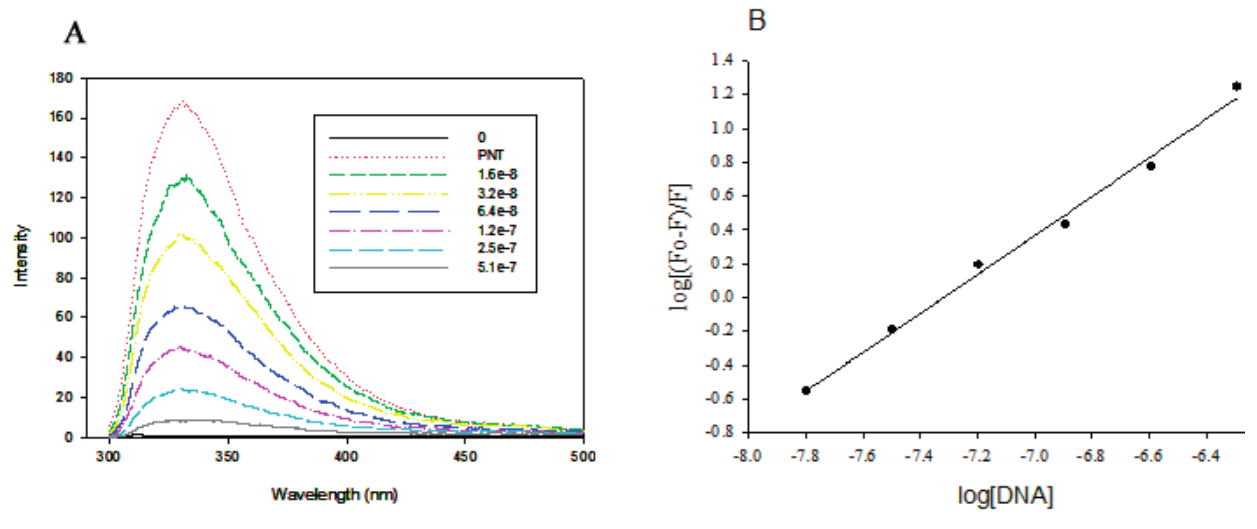
Figure 4. Fluorescence quenching assay of cyclo -( D -Trp-Tyr) peptide nanotubes (PNTs) with CAP3 pRFP-C-RS. ( A ) The emission fluorescence spectra of PNTs at 1.6 × 10 − 8 M upon binding to various concentration of DNA (1.6 × 10 − 8 , 3.2 × 10 − 8 , 6.4 × 10 − 8 , 1.2 × 10 − 7 , 2.5 × 10 − 7 , 5.1 × 10 − 7 M) with excitation at 280 nm for the detection of fluorescence from both of Tyr and Trp residues. ( B ) The linear plot for log( F 0 − F )/F vs. log[DNA] according to Equation (1) with r 2 =